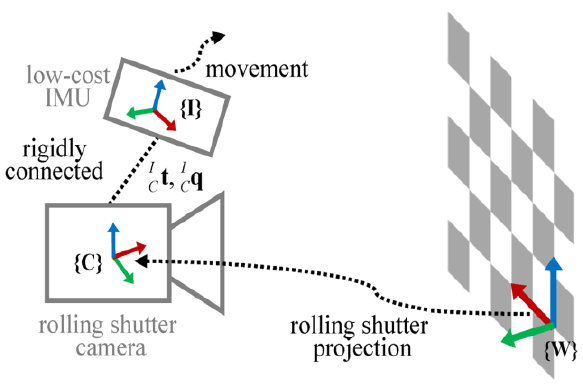
Figure 2. Schematic overview and calibration coordinate description of a simulated smartphone calibration. (Lee et al.,